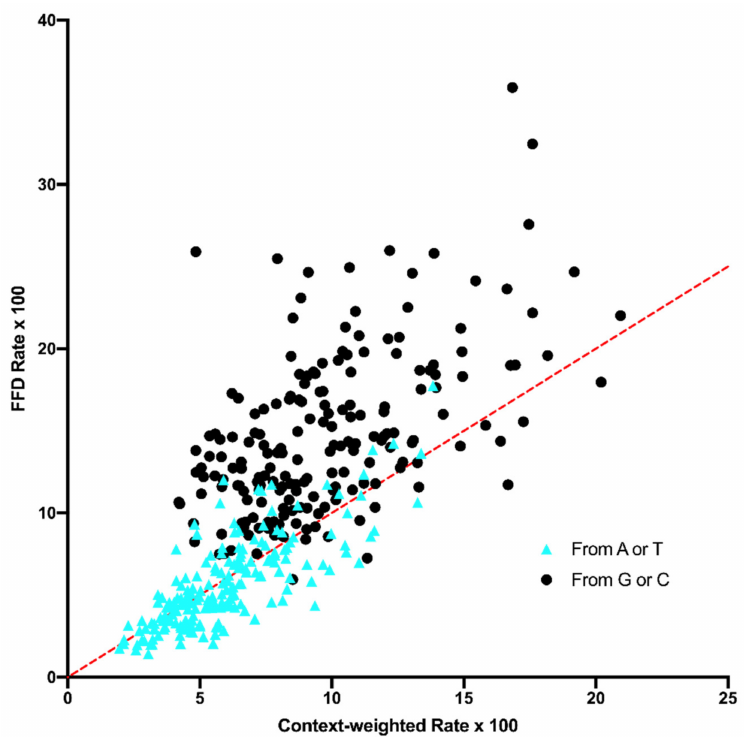
Figure 7. A comparison of context-dependent substitution rates at FFD sites to the R w values, which are weighted by context distribution as described in the text. Substitutions of A or T are shown as a blue